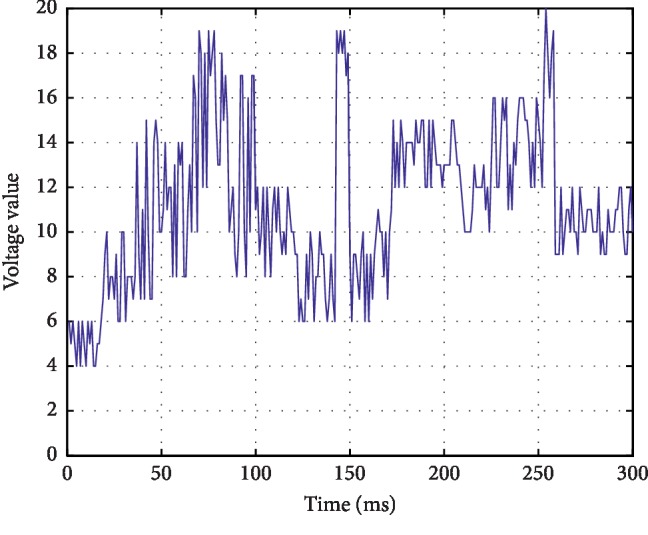
Discontinuous voltage mode above 5 μv.